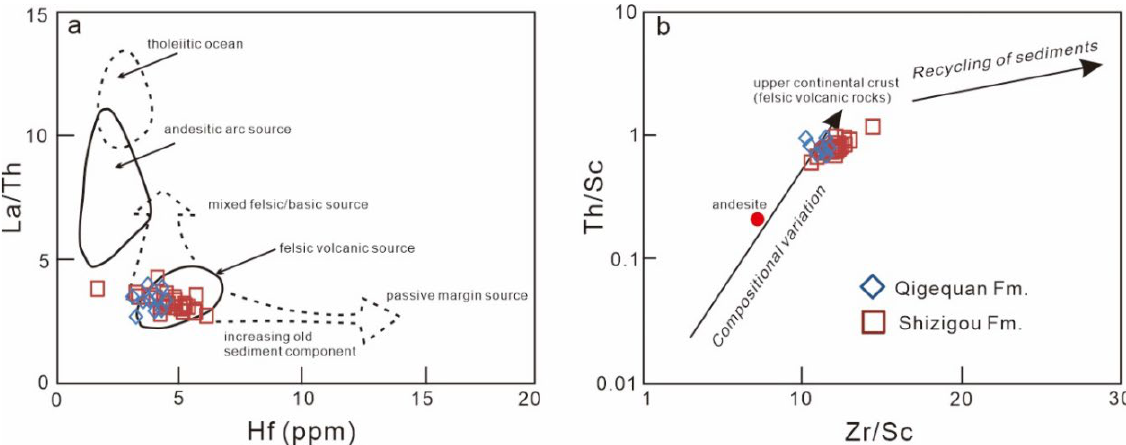
Figure 8. Discrimination binary diagrams of La/Th vs. Hf ( a ) and Th/Sc vs. Zr/Sc ( b ) illustrating sedimentary provenance of the mudstones/silty mudstones collected from the Shizigou Formation and the Qigequan Formation in the Yuejin-II area.